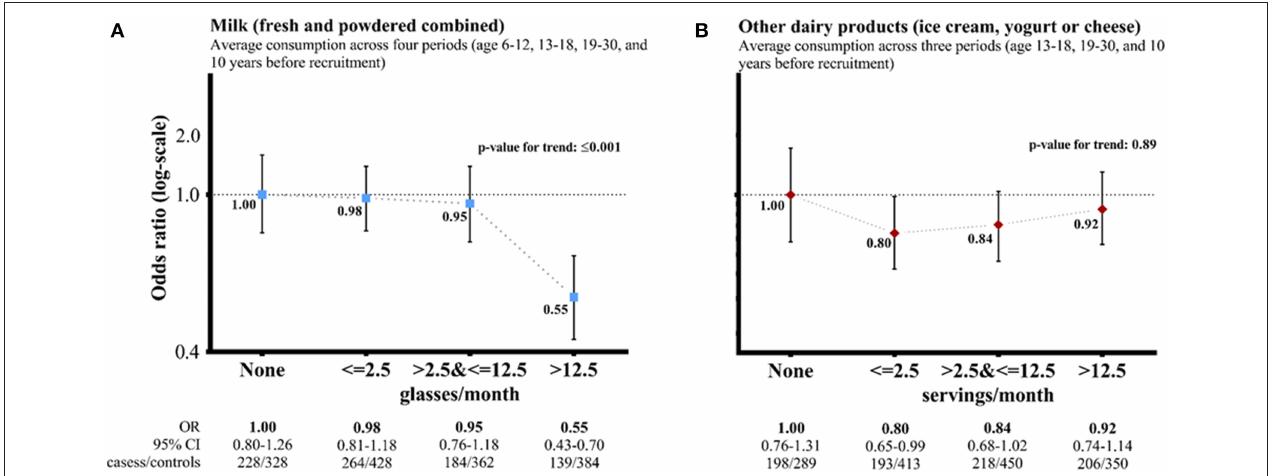
FIGURE 1 | Dairy product consumption and risk of nasopharyngeal carcinoma (cases vs. controls)—adjusted † odds ratios (ORs, 95% confidence interval: CI) comparing average consumption across life periods (three categories) vs. none after multiple imputation = 1 . † Adjusted for sex, age (5-year group), socioeconomic status score, smoking and drinking status, exposure to any occupational hazard, family history of cancer, IgA against Epstein-Barr virus viral capsid antigen, and total energy intake at different life periods as appropriate. = 1 A flexible additive regression model with predictive mean matching incorporating data on the primary outcome (NPC cases vs. controls), exposure (milk or other dairy products) and other covariates included in the multivariate model was used to predict missing values of these factors. CI: group-specific confidence interval for the multivariable OR, reflecting the variance of the log risk in only that one group. The risk estimates did not vary by sex [ P for interaction: 0.52 for (A) and 0.91 for (B) ]. (A) Milk (fresh and powdered combined). (B) Other dairy products (ice cream, yogurt, or